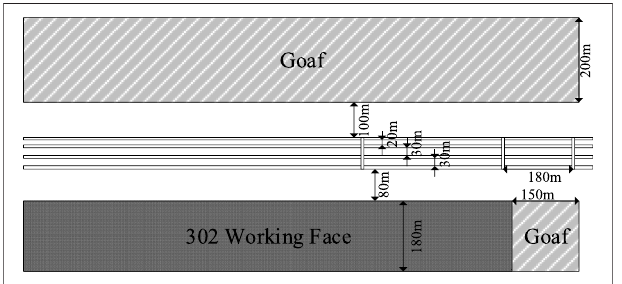
FIGURE 1 | Layout of roadways and working faces on both sides of the island area.